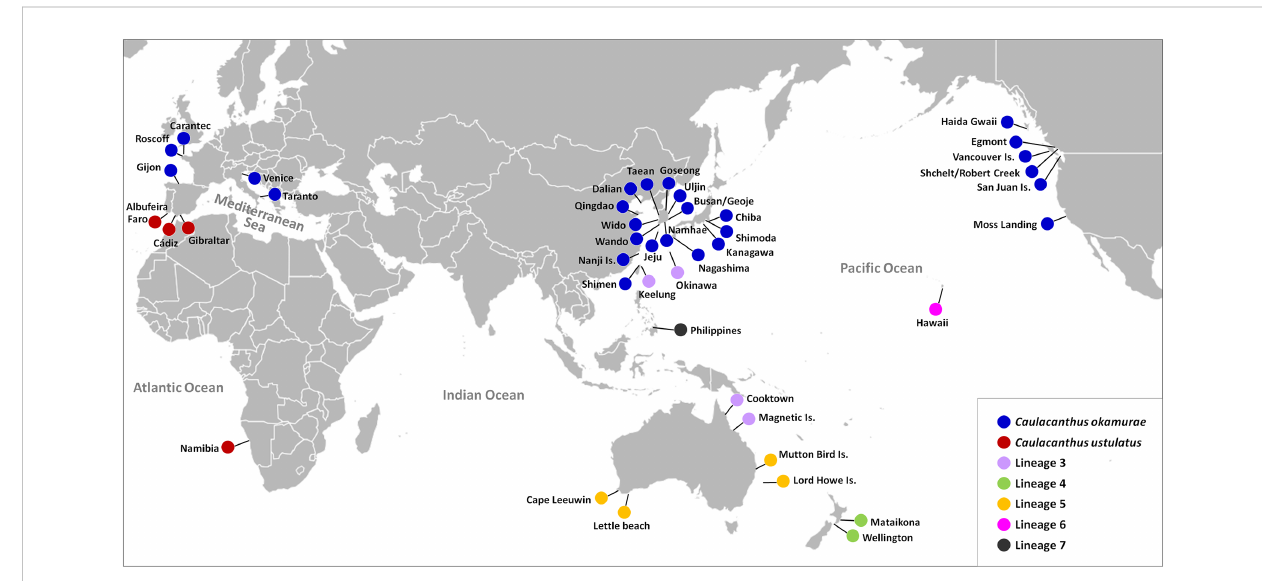
FIGURE 4 Map showing updated global distribution of seven Caulacanthus lineages in the world according to the combined result of mitochondrial and plastid sequence